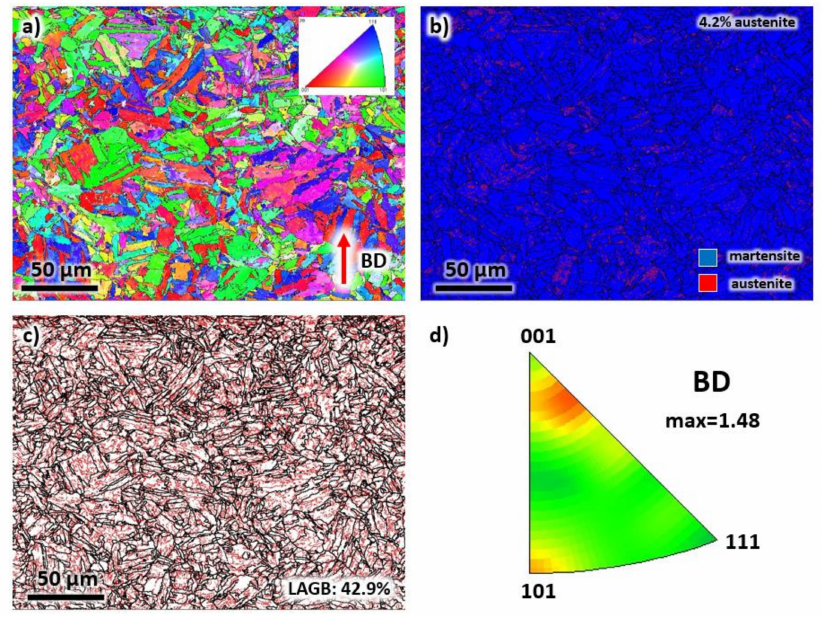
Figure 8. The ( a ) EBSD map, ( b ) phase map, ( c ) grain boundary map, and ( d ) IPF representation of each grain of the heat-treated sample taken from the building direction.